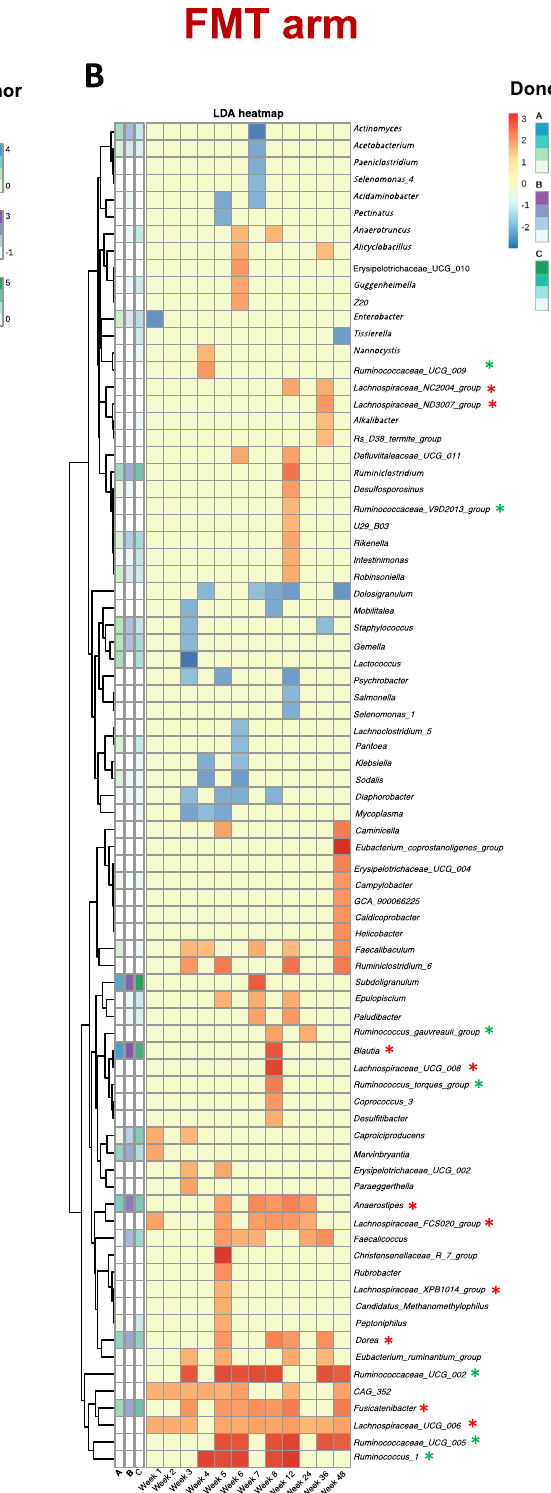
Fig. 5 Heatmap of LDA distances at the genus level from study participants to donors at each time point in the placebo (panel A) and FMT (panel B) groups. For the LDA distances calculations in the participants allocated to receive a placebo, the values represented were calculated as the distances from each timepoint to the assigned donor. Each column represents one timepoint. The three columns represented on the left of the pale-yellow cells represent the distance from the assigned donor to the baseline visit, and inform on the relative abundance of the represented genus on study participants with respect to donors at baseline. Green asterisks identify the genus belonging to the Ruminococcaceae family. Red asterisks identify the genus belonging to the Lachnospiraceae family. Abbreviatures: FMT, fecal microbiota transplant. n = 369 biologically independent samples from 14 individuals in the FMT group, 15 individuals in the placebo group, and 3